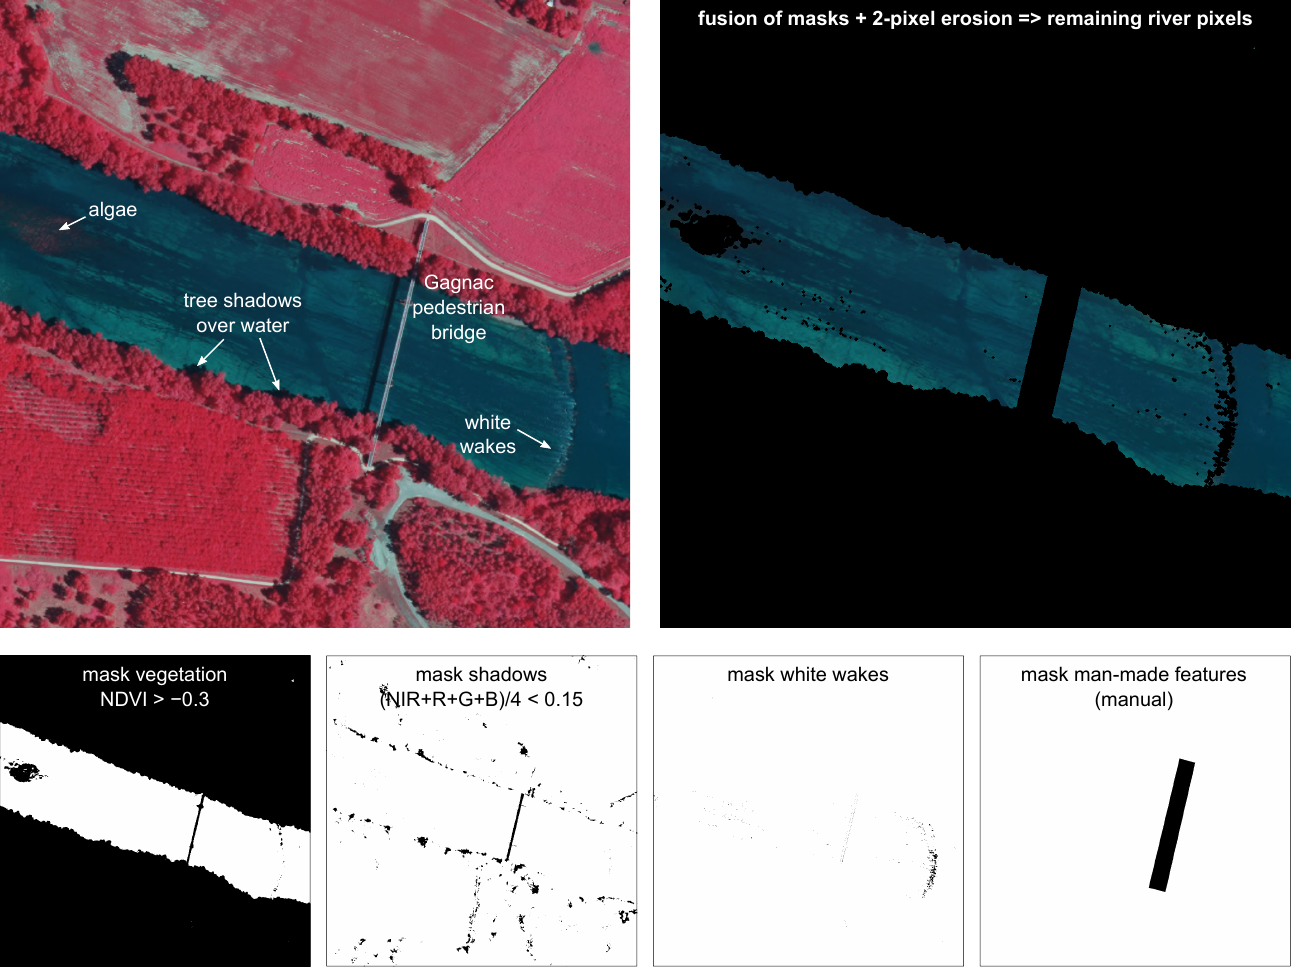
Figure 10. Illustration of the four masks applied to multispectral images in order to retain only river pixels. The image displayed is a NIR-R-G